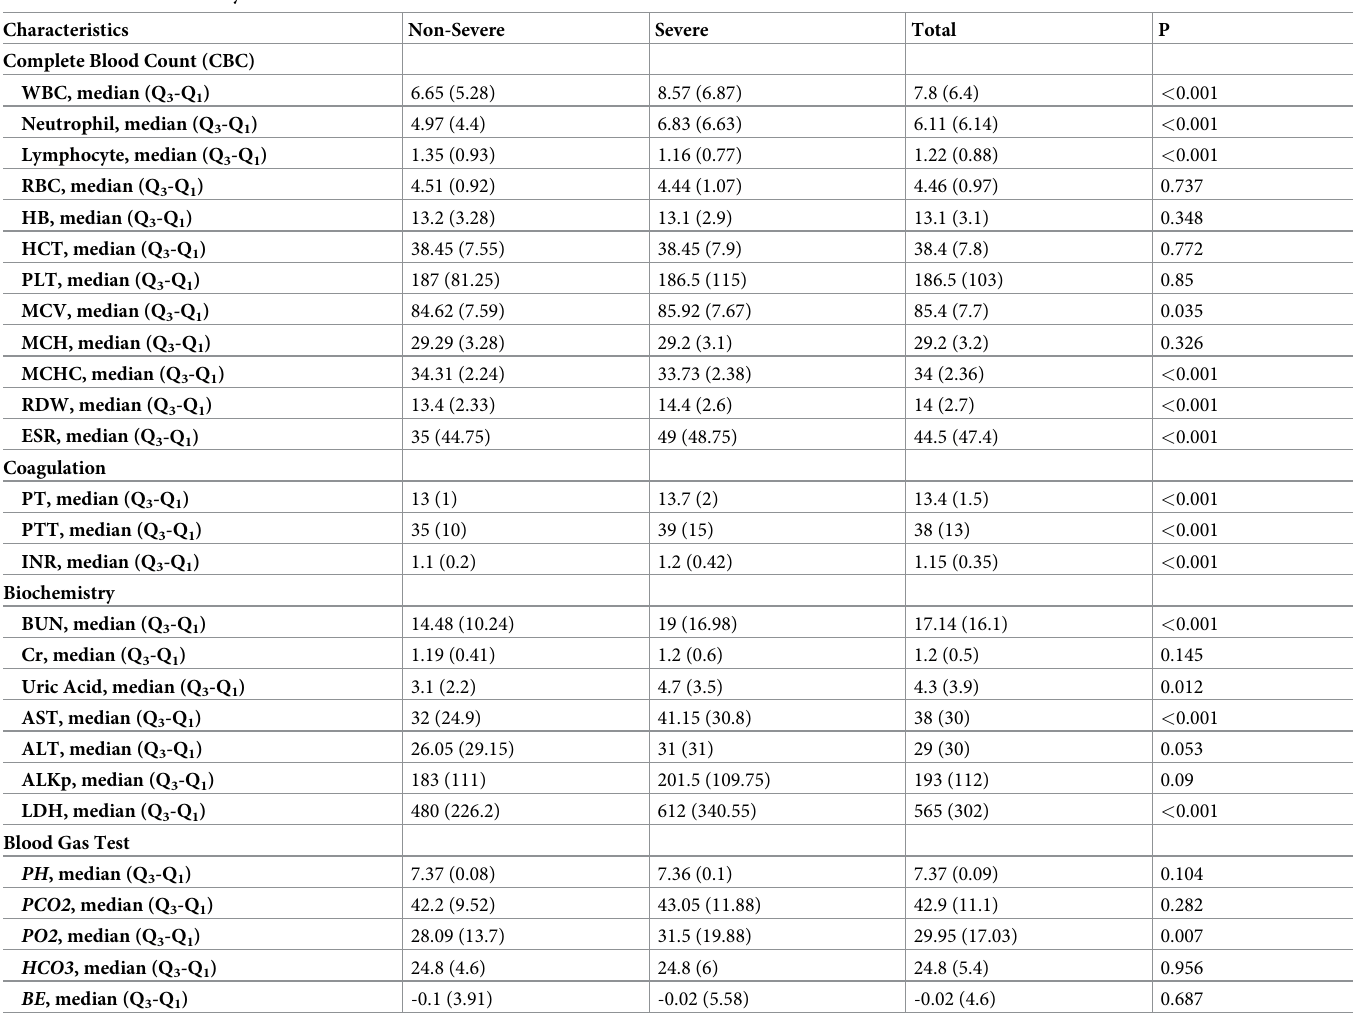
Table 3. Patients’ laboratory data collected from medical records.